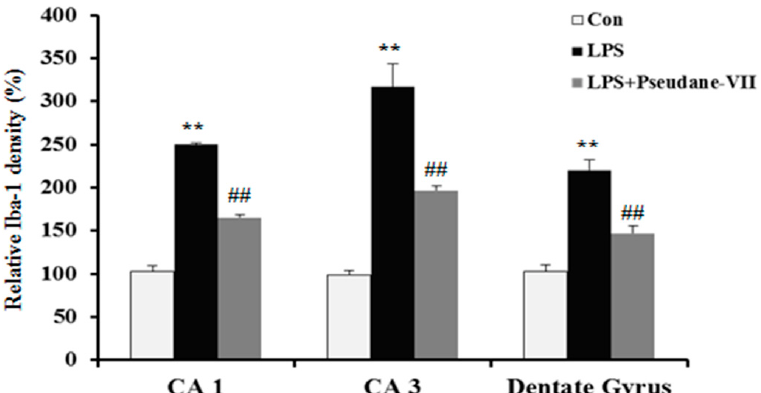
Figure 6. Pseudane-VII reduces the LPS-induced iNOS expression and microglial activation in brain hippocampus. C57BL/6 mice were randomly divided into three groups. The control group was challenged the same amount of solvent i.p. ( n = 5). The treatment group was administered LPS (1 mg/kg) and pseudane-VII (1 mg/kg) as followed in vivo study design. 24 h after the injection, brain was harvested. Brain hippocampus was prepared protein lysates were used for iNOS detection ( A ). ( B ) Brain sections (40 µ m) were immunostained with anti-Iba-1 (a microglia marker) antibody as described in the Materials and Methods. Iba-1 was increased in LPS administered mice brain compared to control. Pseudane-VII suppressed LPS-induced Iba-1-positive cells in CA1, CA3 and DG region of the hippocampus (Scale bar = 100 µ m). Results are expressed as means ( ± SE) from three independent experiments. (** p < 0.01 vs. control group, ## p < 0.01 vs. LPS-stimulated group).